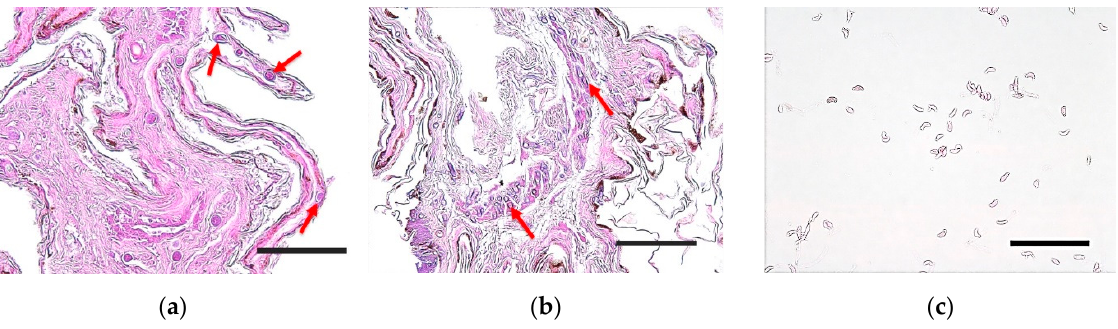
Figure 6. Microscopic analysis of tissue sections and fungal conidia. Hematoxylin and eosin ( a ) and periodic acid–Schiff ( b ) staining of the bat wing tissue sections. Fungal spores were surrounded by a thin layer of acellular material in the skin tissue of the bats (red arrows) (bar = 50 μ m). ( c ) Periodic acid–Schiff-stained conidia of isolated Pd . Fungal conidia of the distinctive curved forms of Pd were identified (bar = 20 μ m).